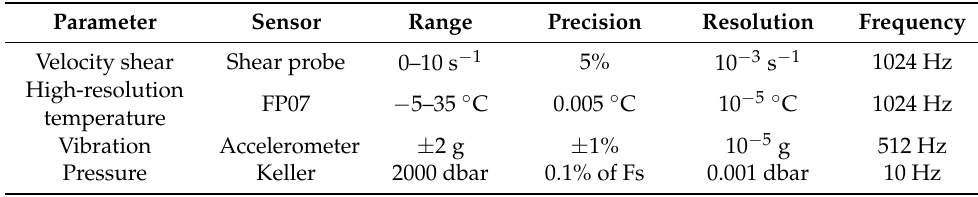
Table 1. Parameters measured with CPMTM, sensor types, and sensor specifications.